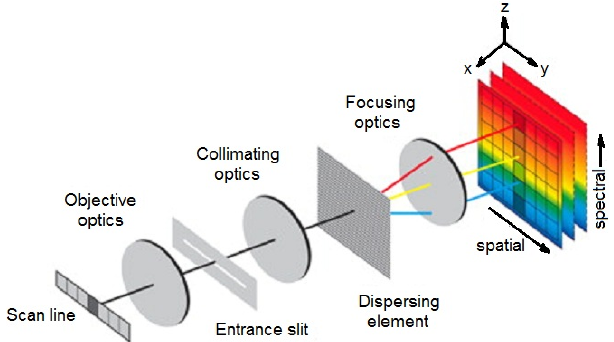
Fig.1: Opticalschemeofanimagingspectrometer. AdaptedfromDellEndiceetal.(2009). Fig. 1. Optical scheme of an imaging spectrometer. Adapted from